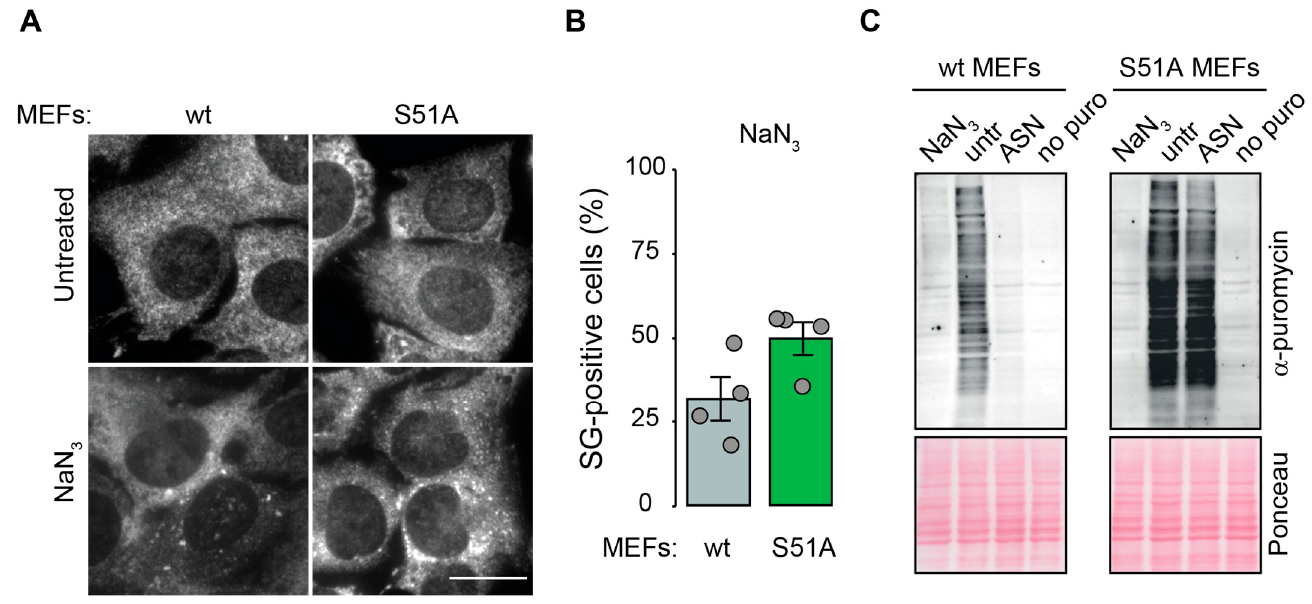
Figure 5. SGs formed upon NaN 3 exposure do not require eIF2 α phosphorylation. ( A ) MEFs were left untreated or treated with NaN 3 for 1 h before fixation. Fixed cells were stained with anti-G3BP1 antibody for IF microscopy, and SG-containing cells were quantified by visual inspection; Scale bar = 20 µm. ( B ) Quantification of A. The graphs show the mean value ± SD ( n = 4 independent experiments; approximately 100 cells were analyzed per experiment and condition). ( C ) Measurement of protein synthesis using a puromycin incorporation assay in MEFs treated with NaN 3 for 1 h, treated with ASN (500 µM) for 1 h, or left untreated. As a control, a sample without puromycin labeling was also loaded.